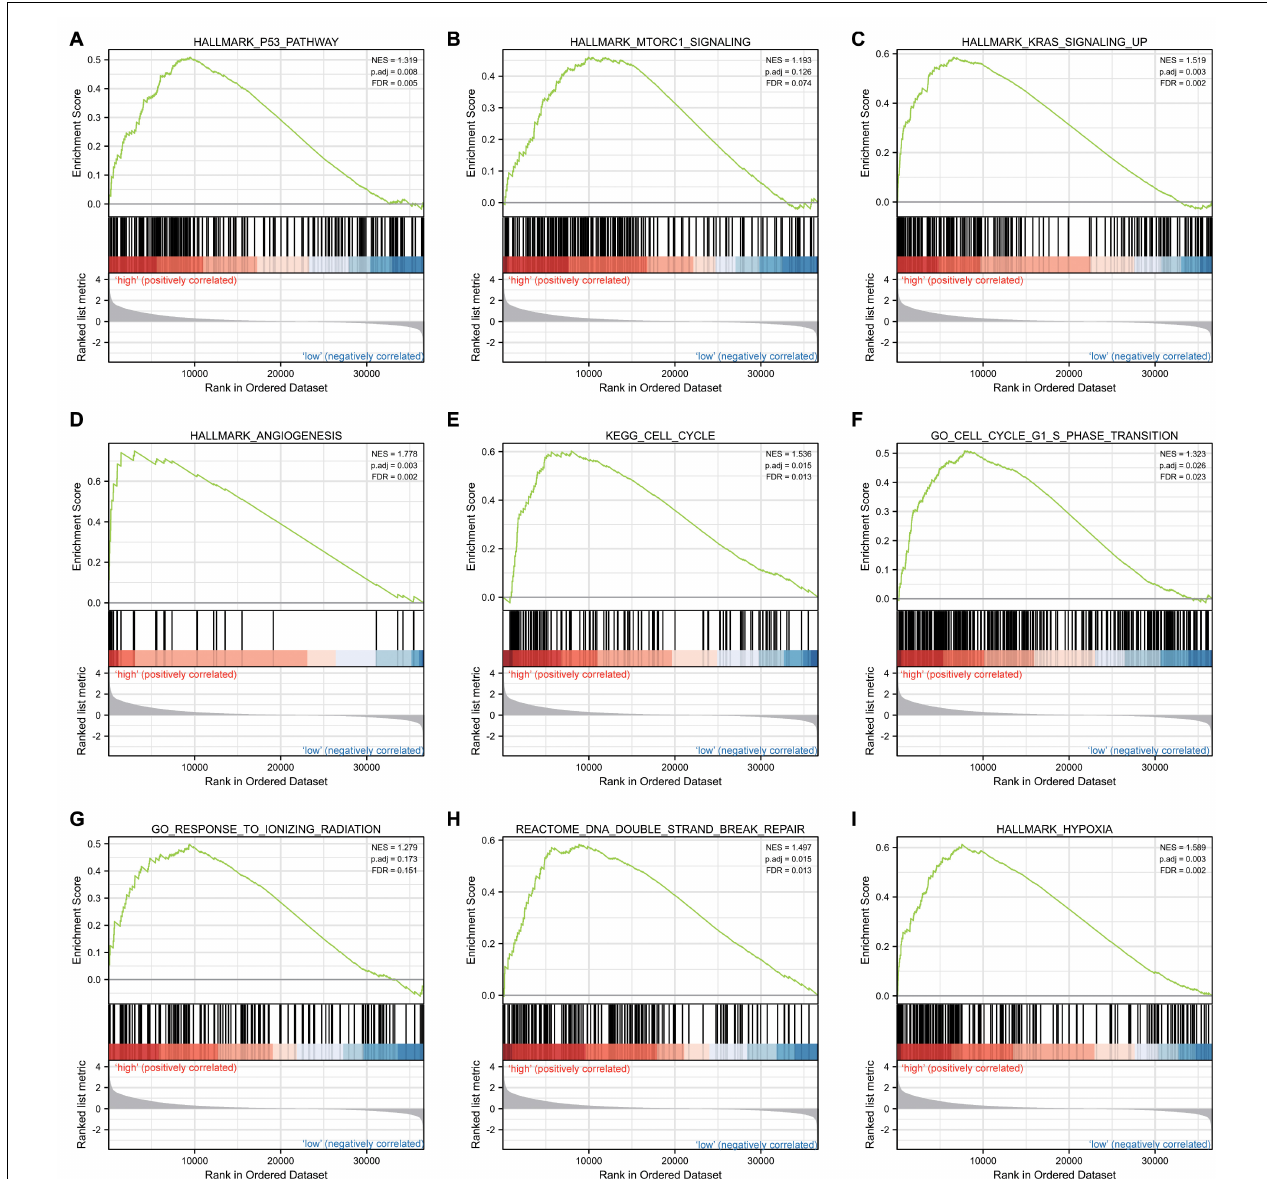
FIGURE 9 | Enrichment plots from gene set enrichment analysis (GSEA). Several pathways and biological processes were enriched, including the (A) p53 pathway, (B) MTORC1 signaling, (C) KRAS signaling, (D) angiogenesis, (E) cell cycle, (F) cell cycle G1 S phase transition, (G) response to ionizing radiation, (H) DNA double strand repair and (I)